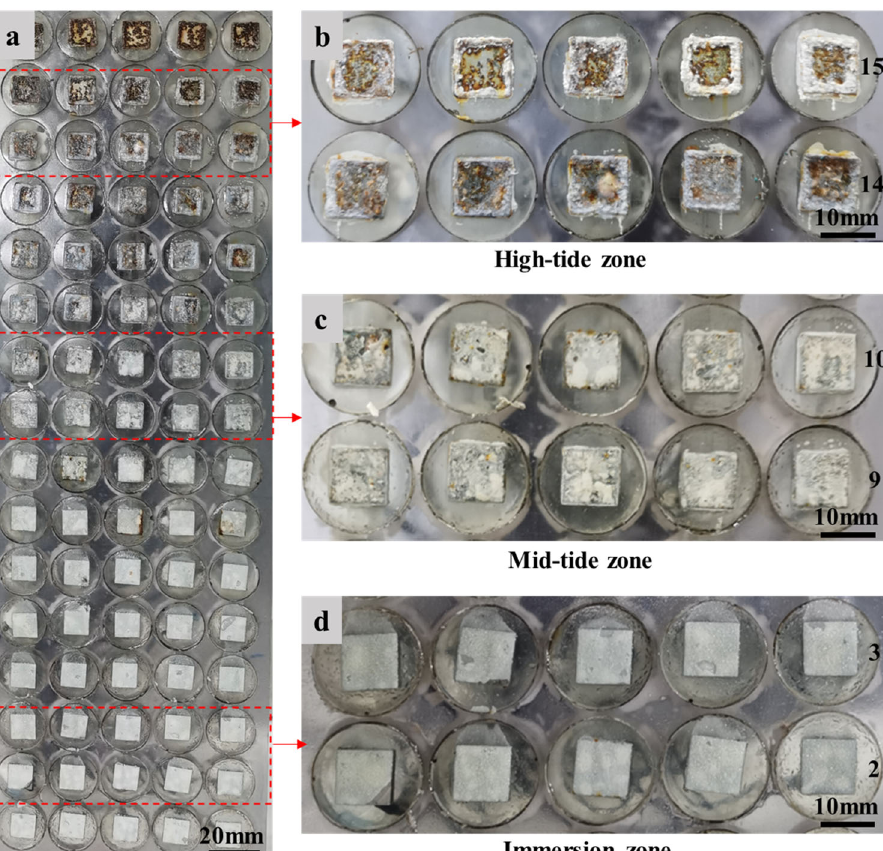
Fig. 1 Images of electrode surfaces. a Entire electrode surface. b Magni fi ed images of the local areas: 14 and 15 rows. c 9 and 10 rows. d 2 and 3